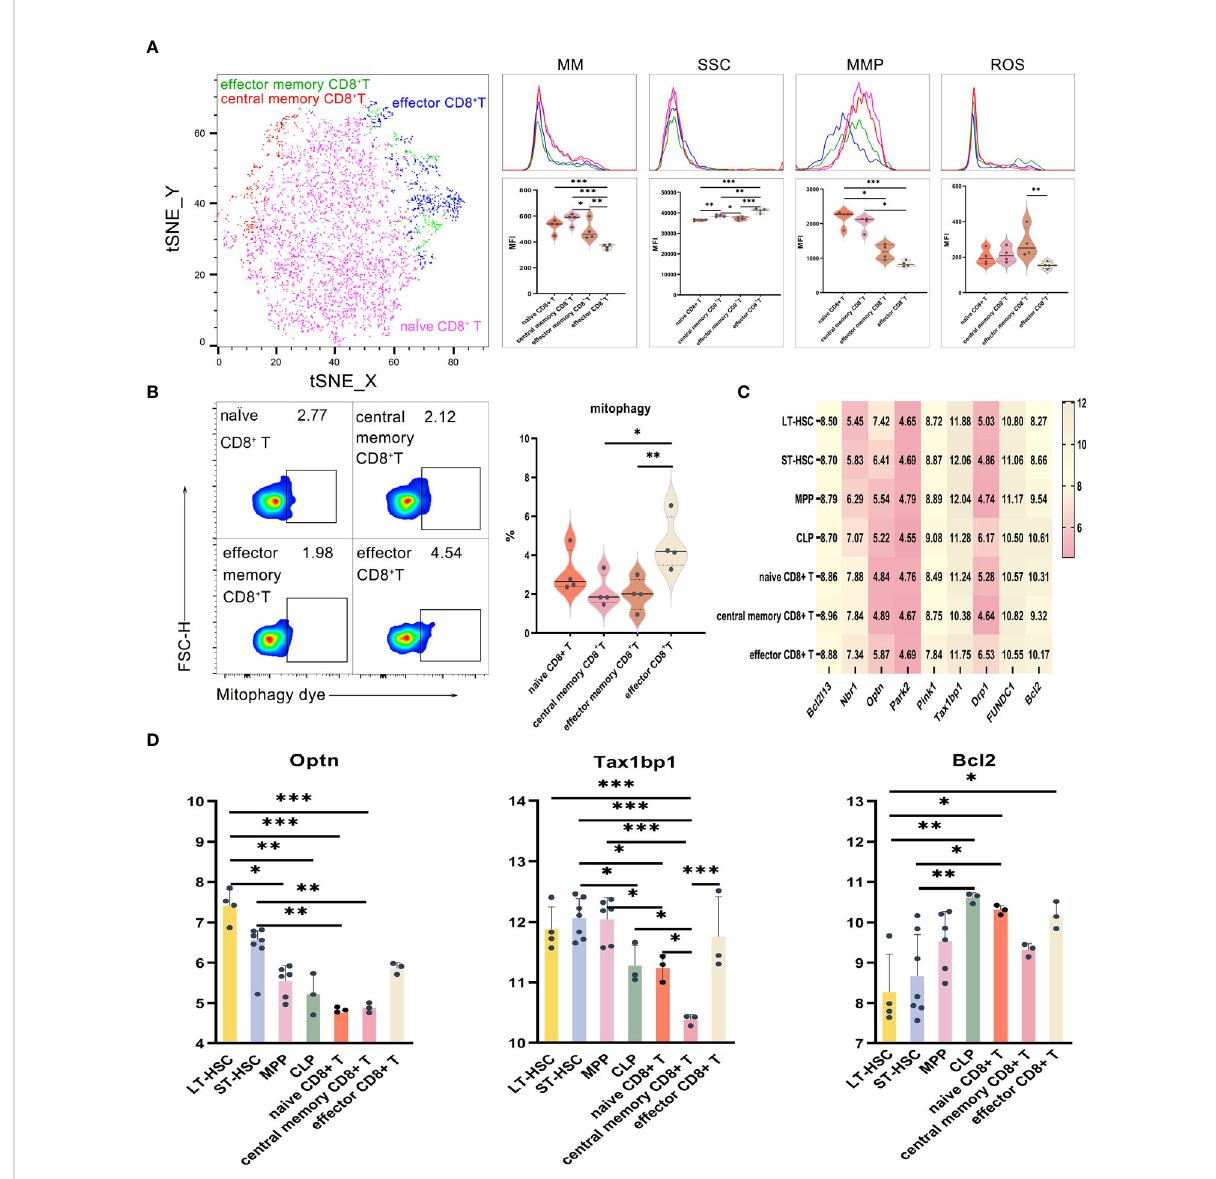
FIGURE 5 (A) t-SNE, MM, SSC, MMP and ROS in effector CD8 + T, CD8 + Tem and CD8 + Tcm (B) Mitophagy in effector CD8 + T, CD8 + Tem and CD8 + Tcm (C) Heat map for the expression levels of autophagy-related genes in CD8 + T cells at different differentiation and activation stages (D)